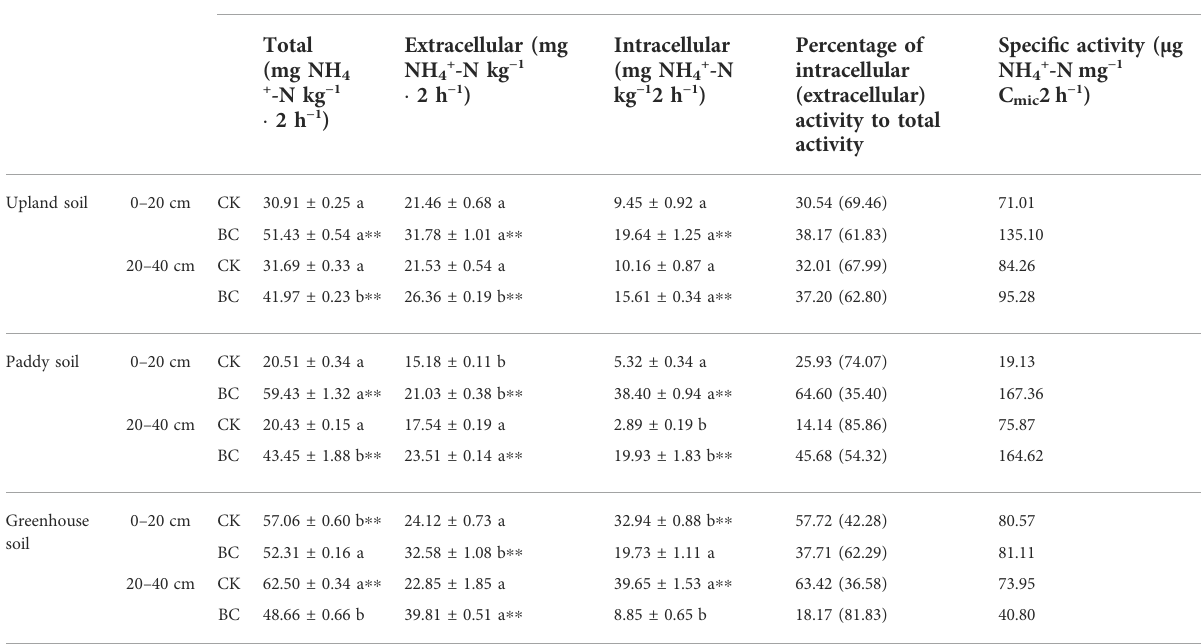
TABLE 1 Effect of long-term biochar application on the urease activity of various pools in the soils.